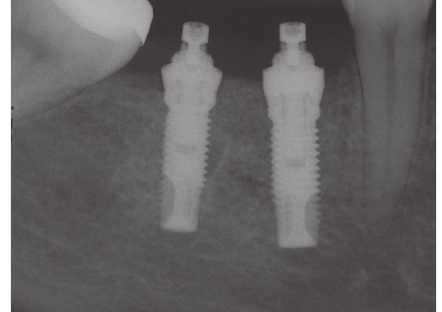
Figure 1: Periapical radiograph at abutment connection.